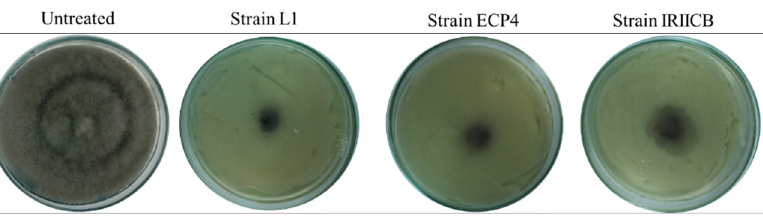
Figure 1. Effect of D. hansenii on the mycelial growth of B. cinerea. Table 1. Inhibition of mycelial growth of B. cinerea under application of D. hansenii strains.